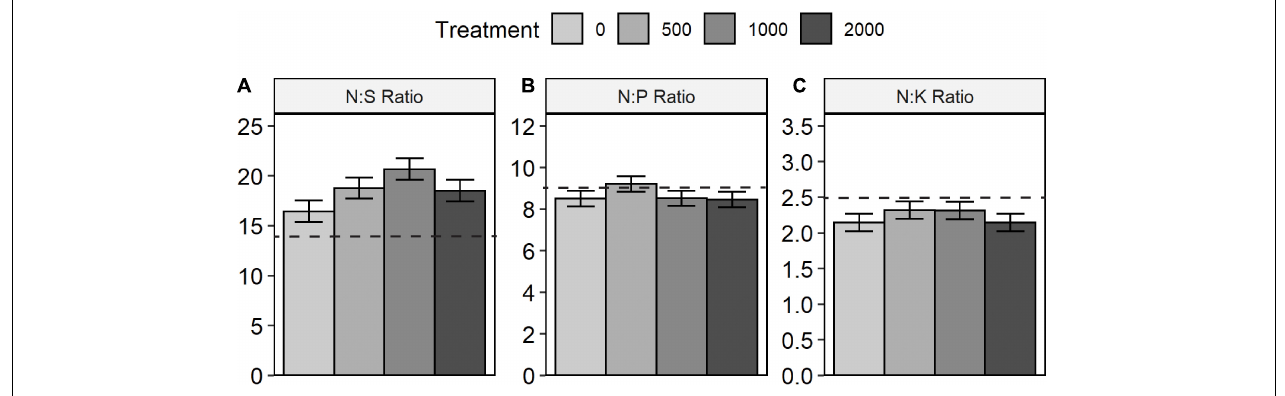
FIGURE 7 | Lodgepole pine foliar nutrient ratios with nitrogen (N): (A) N:S (sulfur), (B) N:P (phosphorus), and (C) N:K (potassium). Values below dashed horizontal lines indicate no deficiency of S, P, or K, respectively, (Brockley,